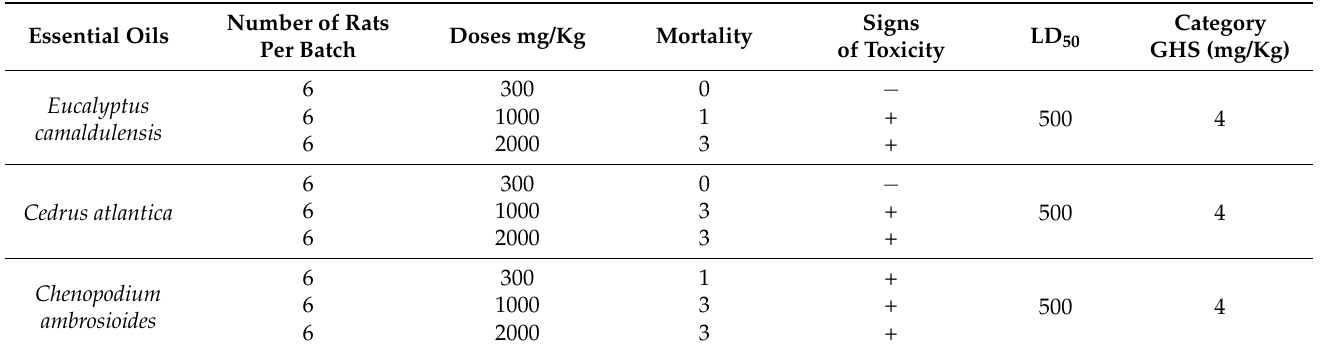
Table 5. Results of acute oral toxicity tests of oils with different